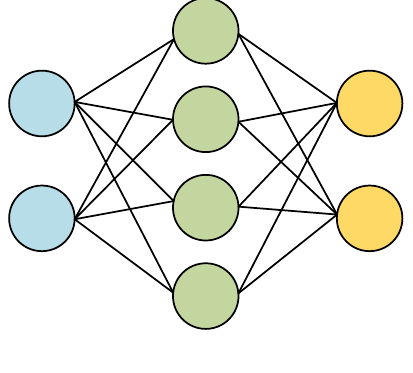
Figure 10. Neural network model.